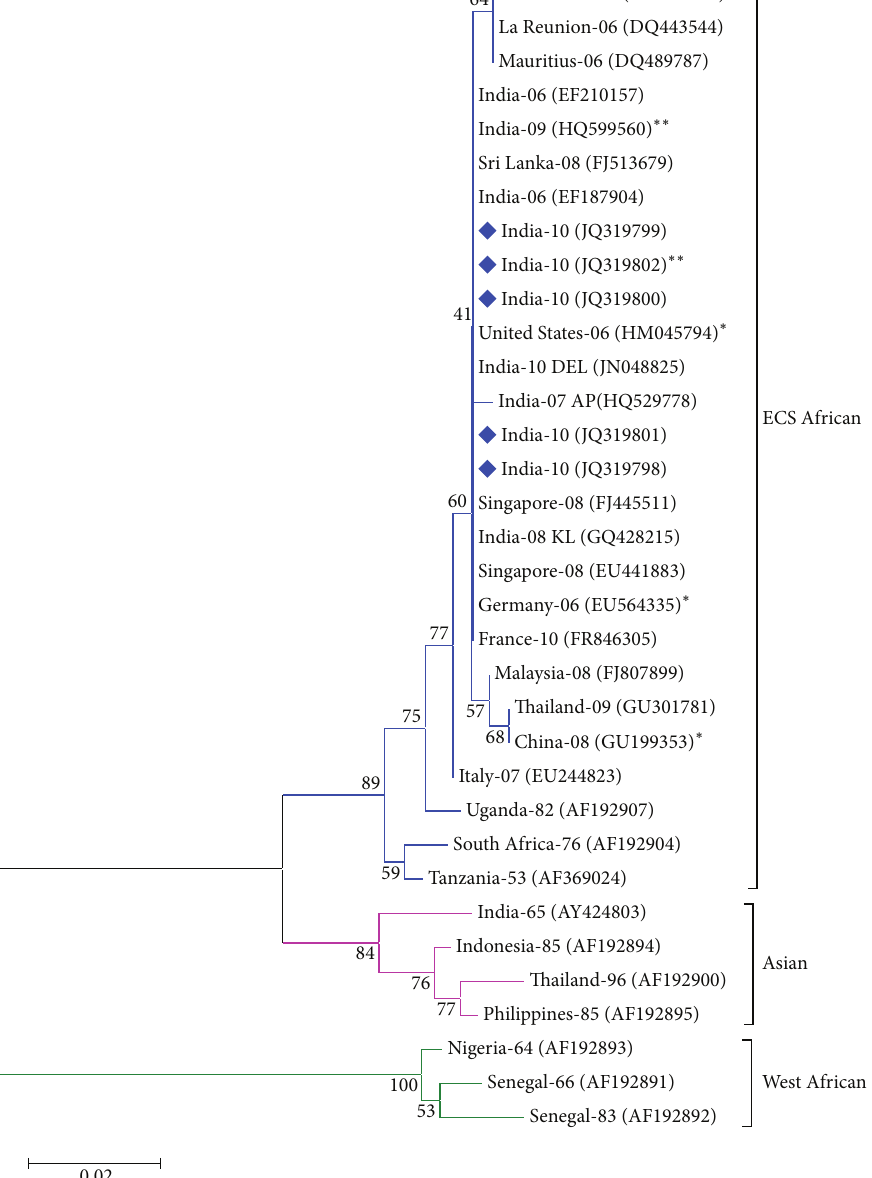
also reported from other parts of India [13, 20]. The